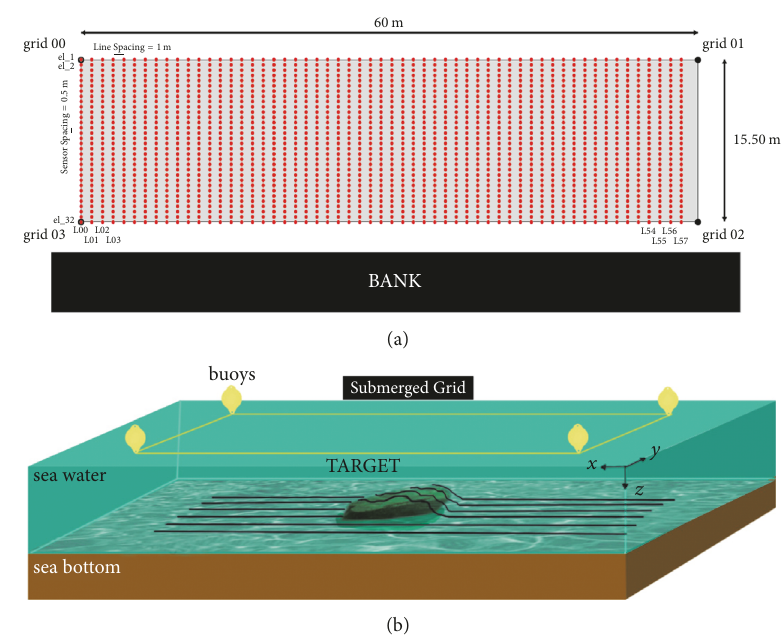
Figure 7: Selected survey grid. Red dots indicating electrode position (a). Cables submerged at the river